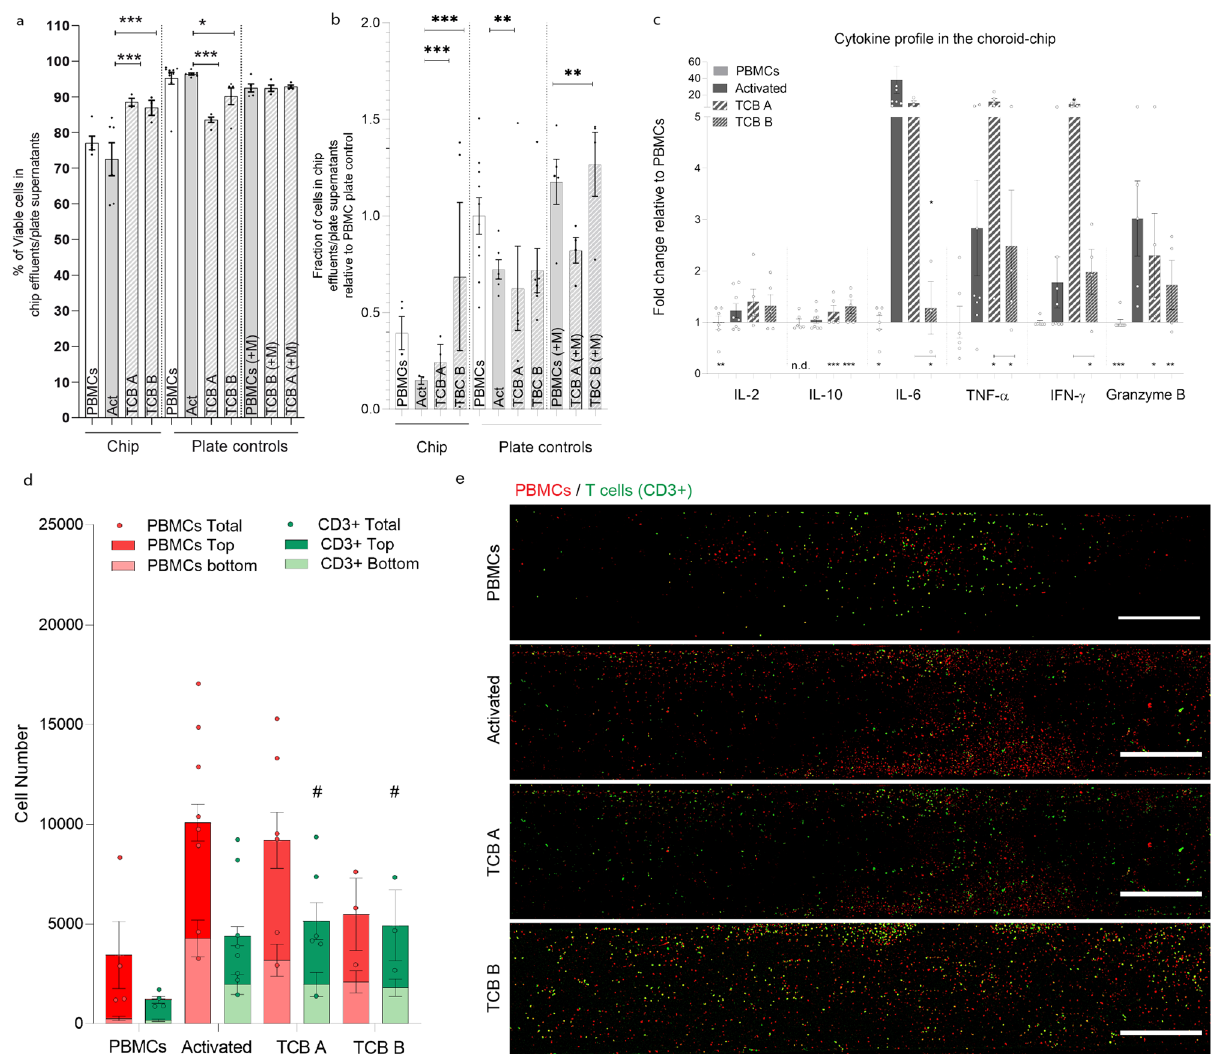
Fig. 6 Effect of the TCBs on the Immuno-competent Choroid-chip with low melanocyte density after 24 h of perfusion or cell culture (plate controls) respectively, in PBMCs treated and non-treated with TCB A or TCB B (5 µ g/mL). a Viability of the immune cells collected in the chip ef fl uents and plate control supernatants ( n = 3 – 10, the dots represent each data point). b Fraction of cells recovered in the chip ef fl uents and plate control supernatants relative to the number of recovered cells in the PBMC control ( n = 3 – 10). c Cytokine pro fi le in the TCB A and TCB B treated choroid chips relative to PBMCs ( n = 6 – 12). d Quanti fi cation of immune cell recruitment by image analysis of the whole chip, distinguishing PBMCs (cell tracker labeled prior perfusion) and T cells (CD3 post fi xation staining) in the top (dark red and green) and bottom (light red and green) halves of the melanocyte compartment chips with low melanocyte density ( n = 3 – 9). e Representative images of the melanocyte compartment containing labeled PBMCs (Cell tracker, red) and T cells (CD3, green) represented as maximum intensity projections for each of the analyzed condition. Scale bar = 500 µ m. Bars represent Averages ± SEM. Statistical analysis represents the comparison of the TCBs treatment in PBMCs with cells activated with antiCD3/CD28 beads (* P < 0.1, ** P < 0.05, *** P < 0.01), unless labeled otherwise, and the comparison of the total and bottom compartments of the TCBs treatment in PBMCs with non- treated PBMCs ( # P < 0.1). Statistical analysis is detailed in Supplementary data 1, including detailed information of the number of biological replicates per group, exact p values and individual data